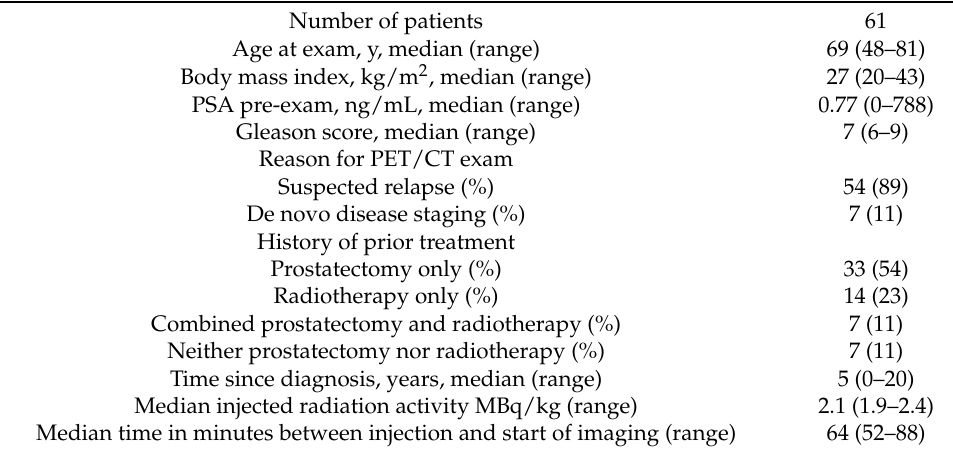
Table 1. Patient and tumor